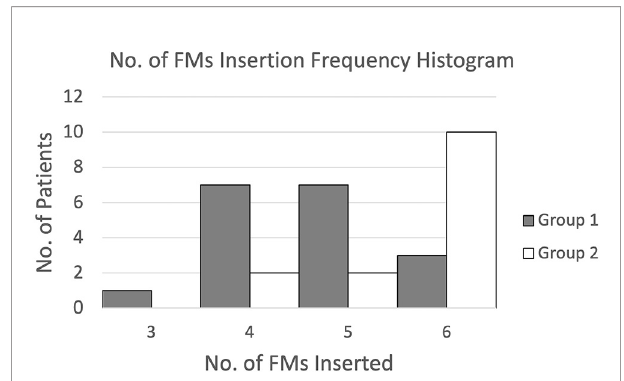
FIGURE 9 | Histogram of the number of FM insertion